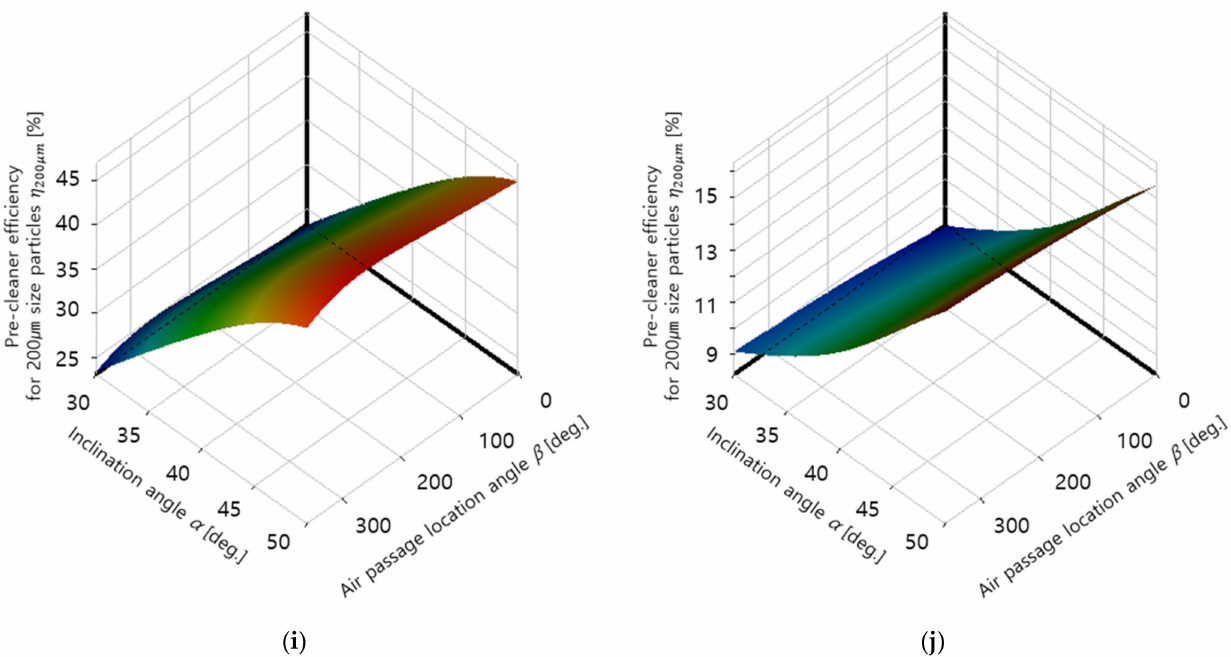
Figure 9. Response surface of pre-cleaner efficiency η i for dust particle of each size according to change of design variables α and β : ( a ) 4500 rpm, dust size = 10 µ m; ( b ) 6000 rpm, dust size = 10 µ m; ( c ) 4500 rpm, dust size = 50 µ m; ( d ) 6000 rpm, dust size = 50 µ m; ( e ) 4500 rpm, dust size = 100 µ m; ( f ) 6000 rpm, dust size = 100 µ m; ( g ) 4500 rpm, dust size = 150 µ m; ( h )